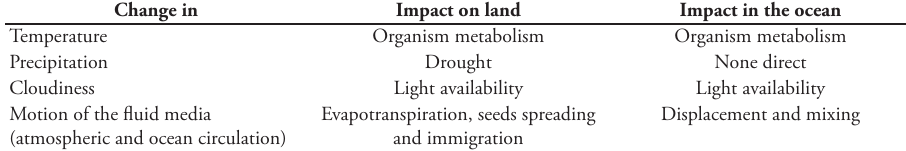
Table 1. Climate components and their direct impact on terrestrial and marine ecosystem